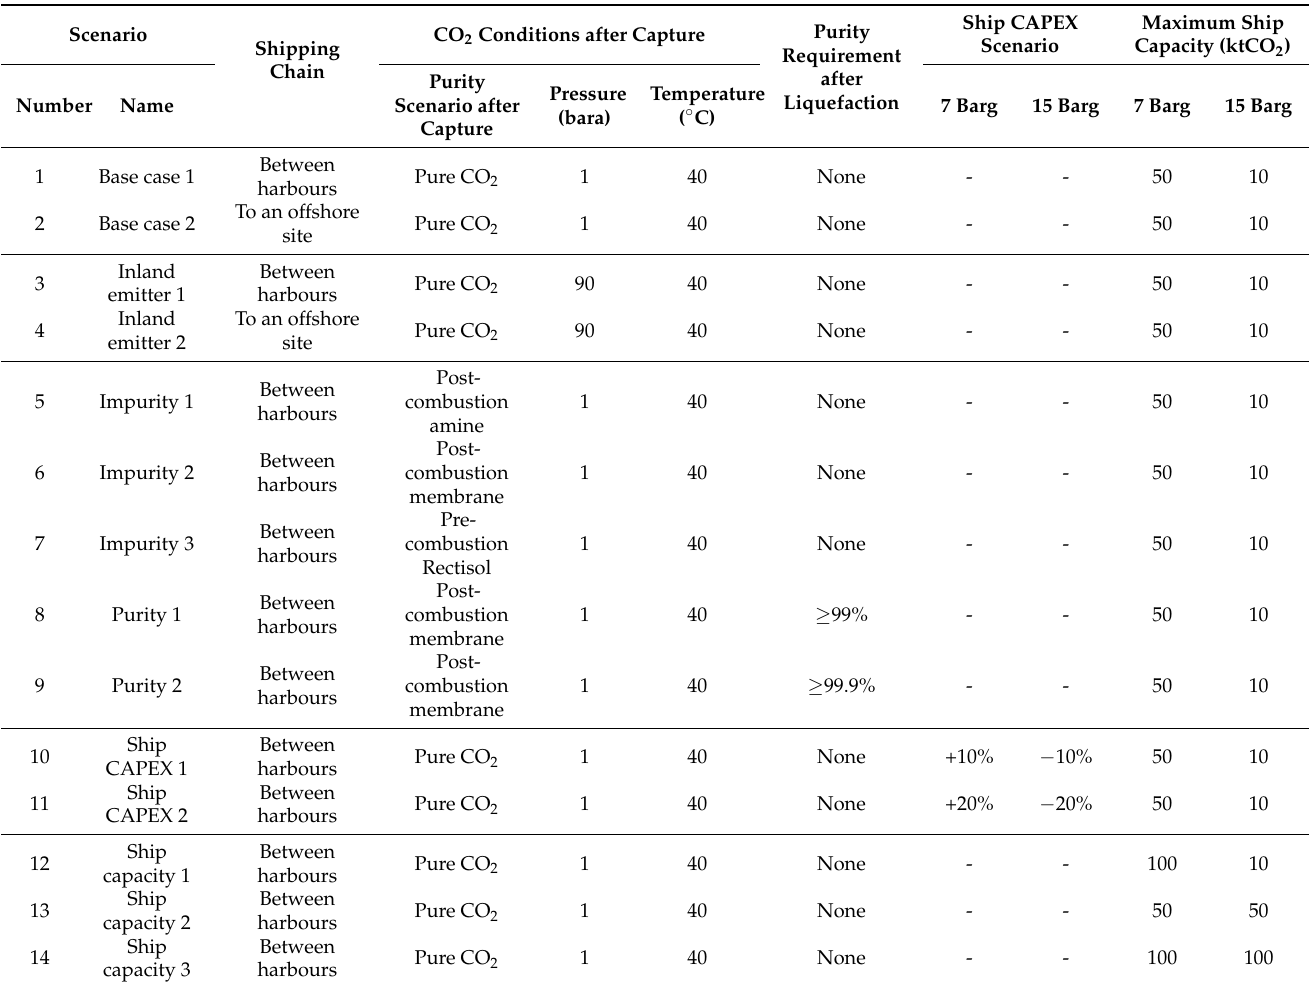
Table 2. Summary of the base cases and alternative scenarios together with their